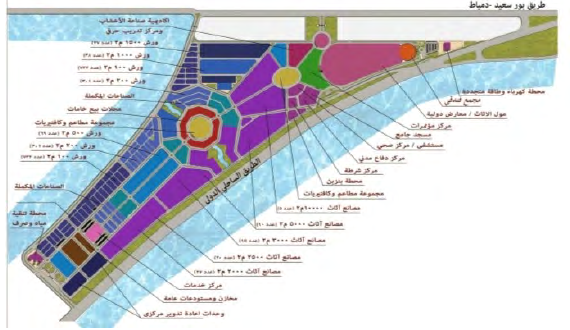
Figure 9. NewFurniture City Master